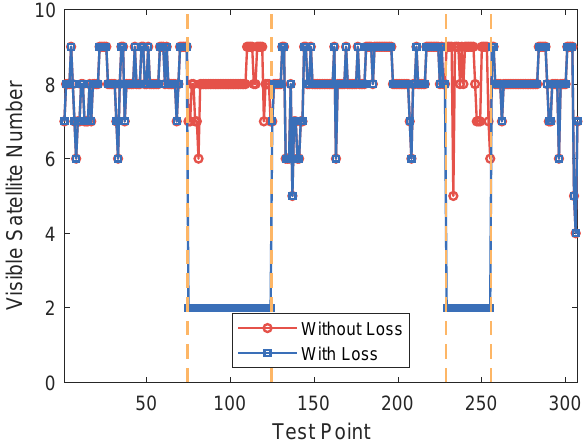
Figure 18. Number of available satellites at each test point at Site 2.